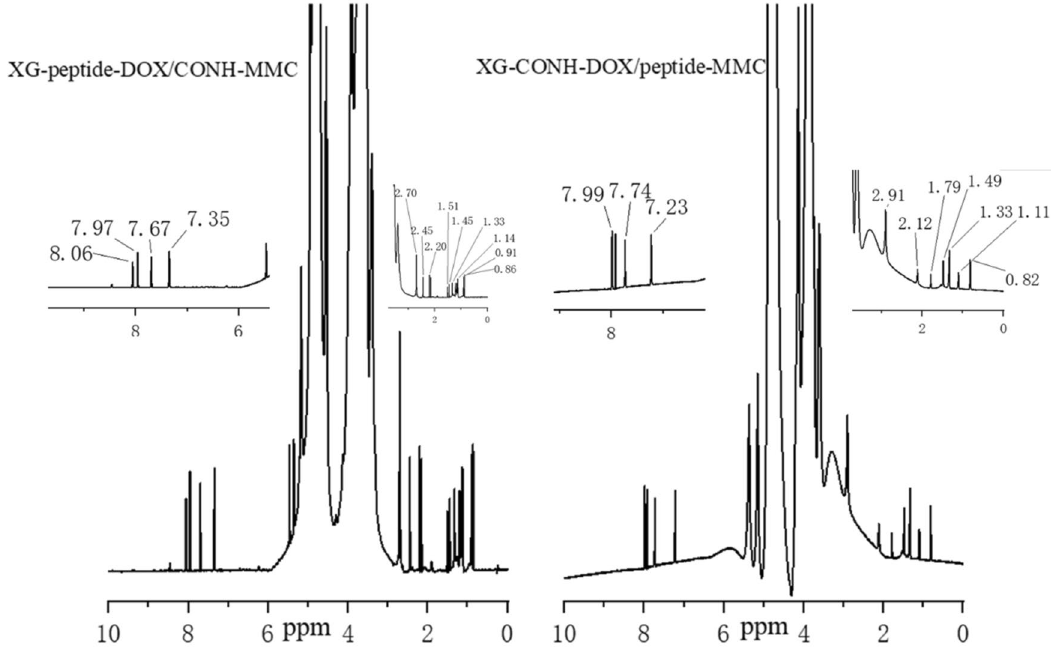
Figure 3. 1 H NMR spectroscopy of XG-peptide-DOX/CONH-MMC and XG-CONH-DOX/peptide-MMC conjugates.